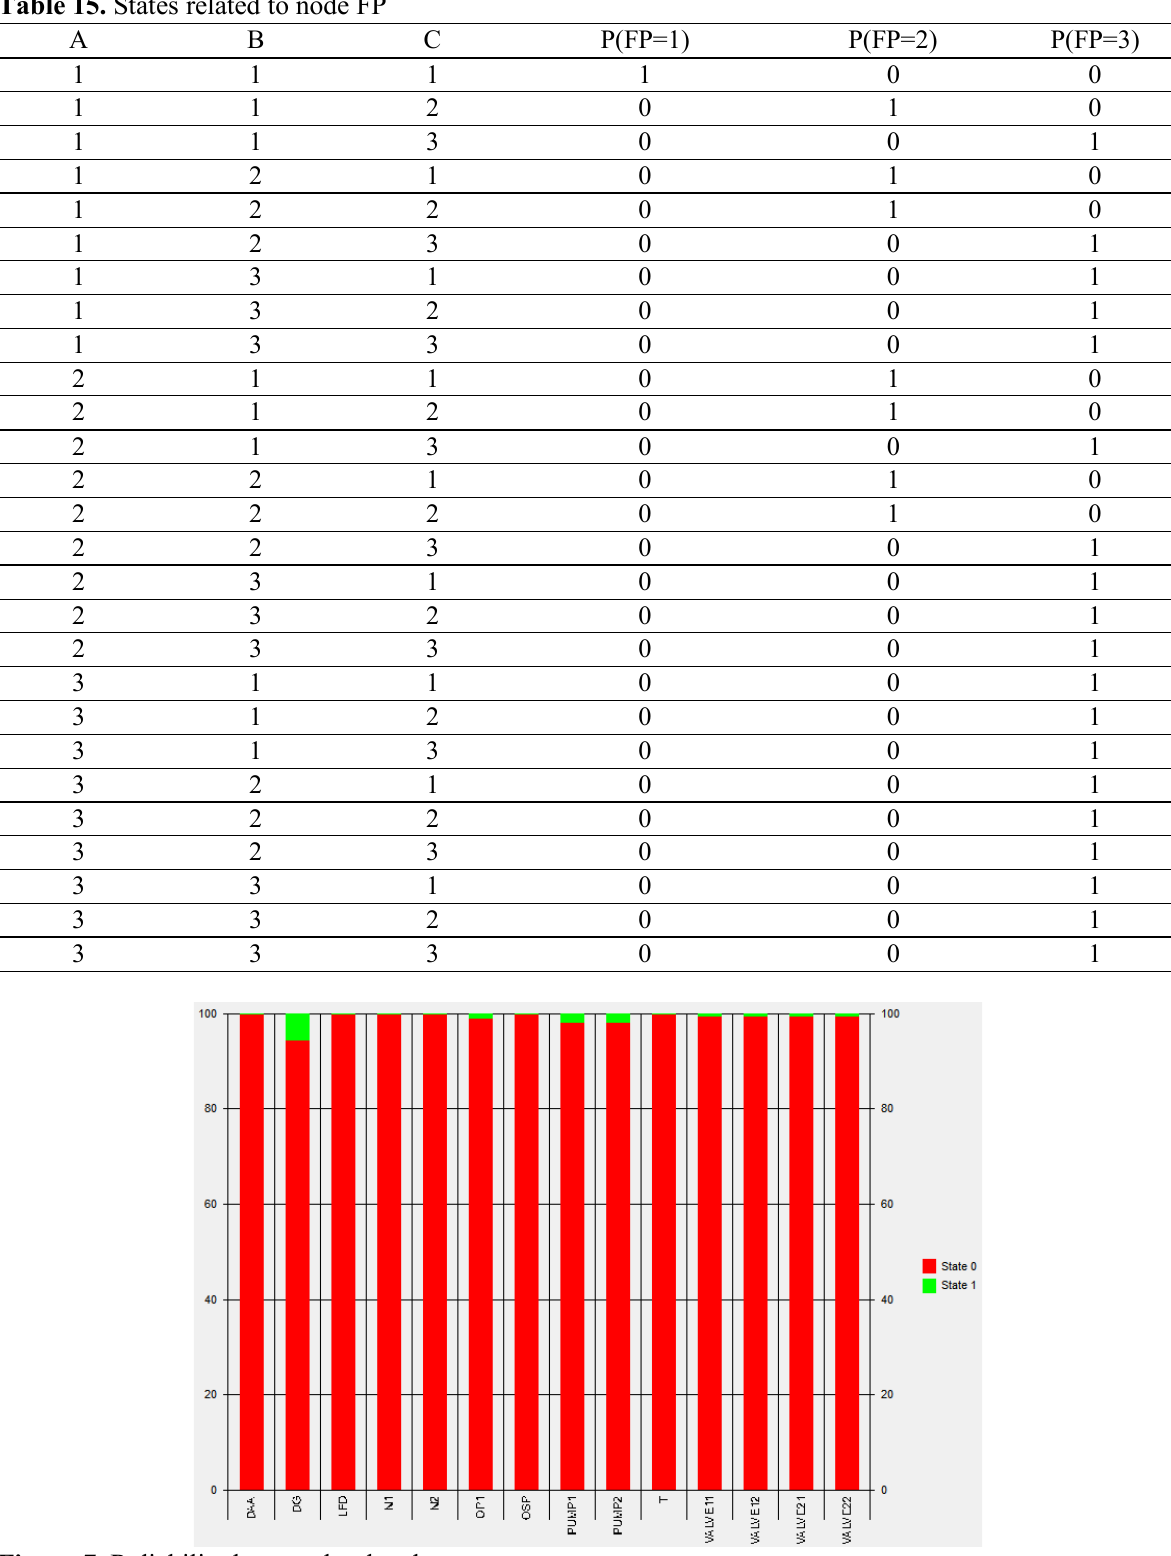
Figure 7. Reliability bar graph related to system